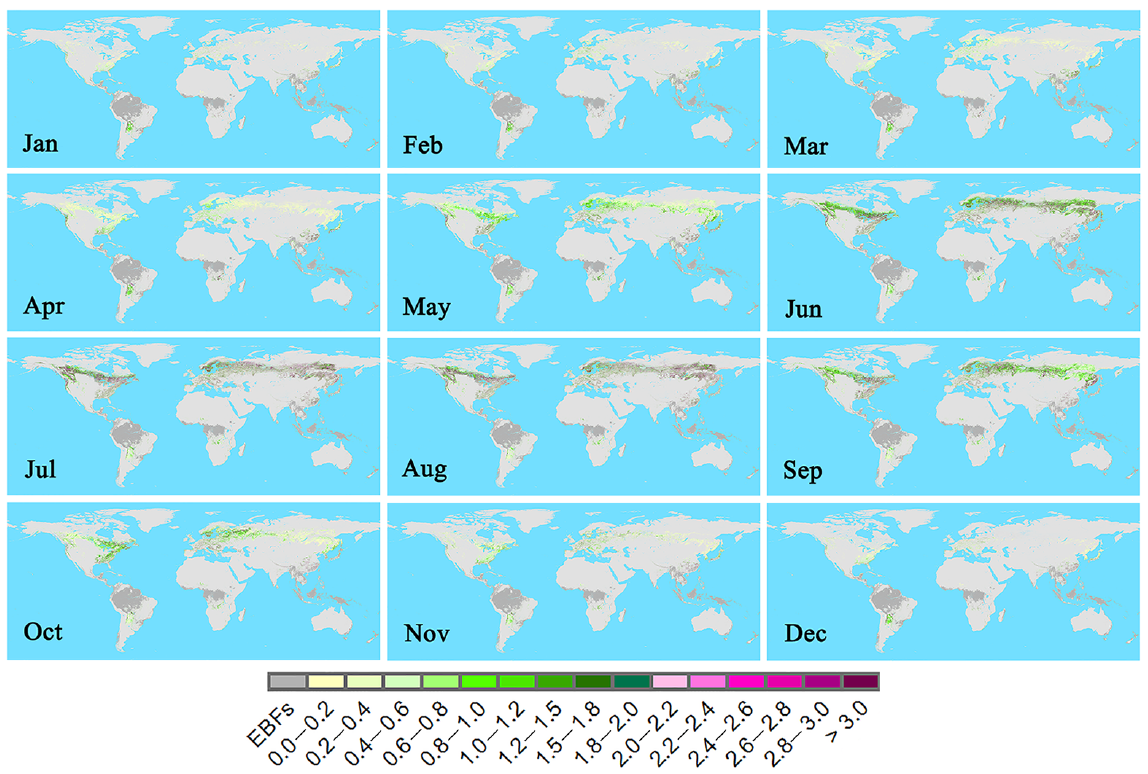
Figure 4. Global monthly GLOBMAP forest understory LAI maps by averaging valid retrievals during 2000–2010 for each month. Because notable uncertainties in the retrieved understory LAI are introduced for EBFs in the tropical zones due to the unreliability of the forest background reflectivities in this biome, the results from EBFs are excluded.